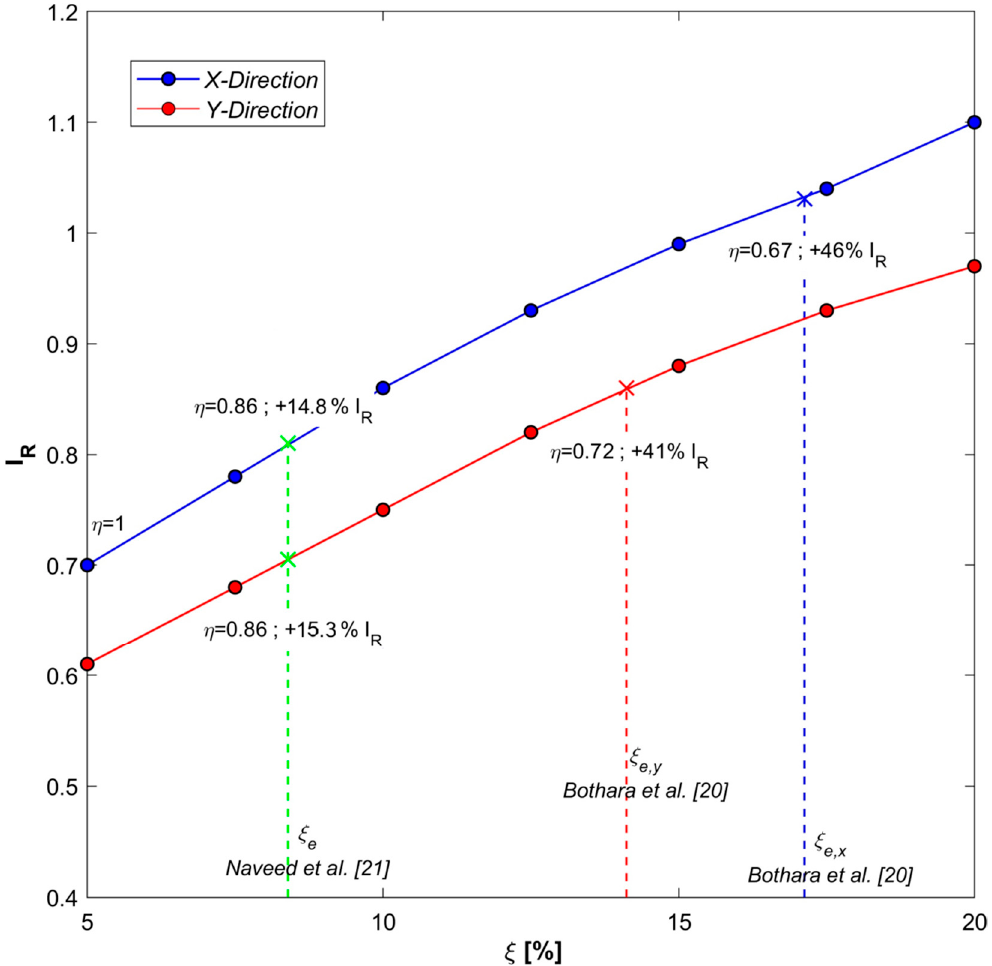
Figure 3. Variation of seismic risk index as a function of damping coefficient 𝜉 .